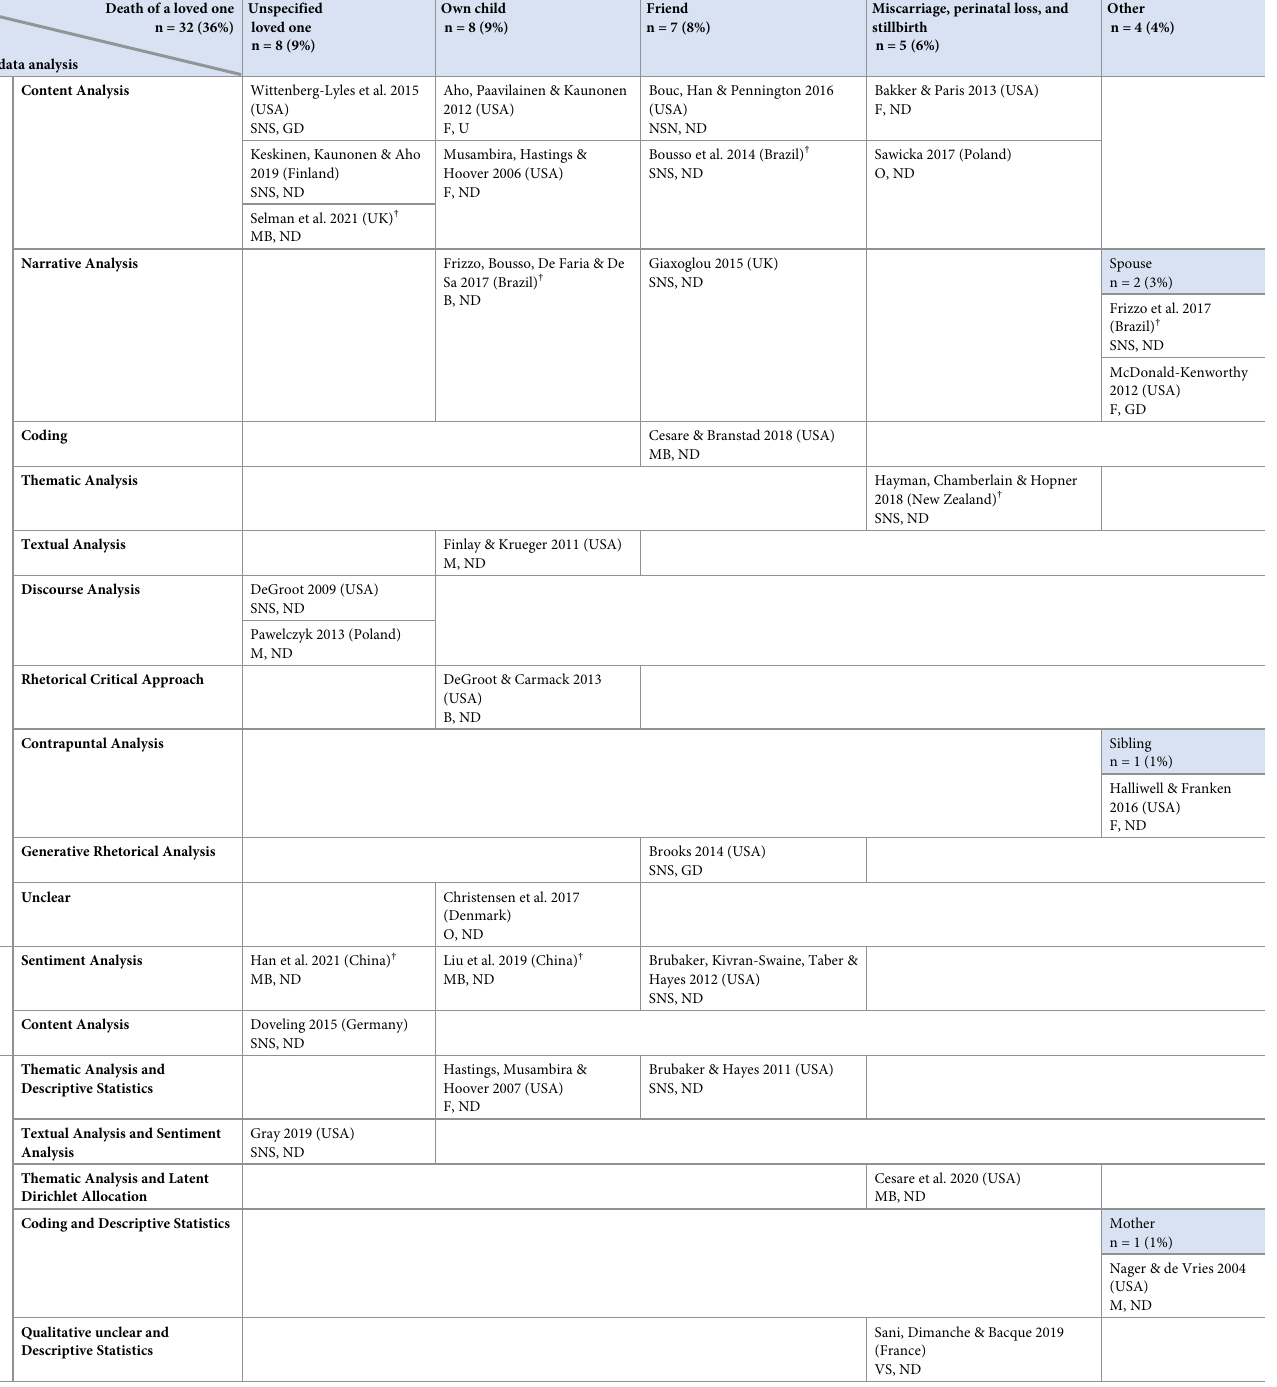
Table 2. Death of a loved